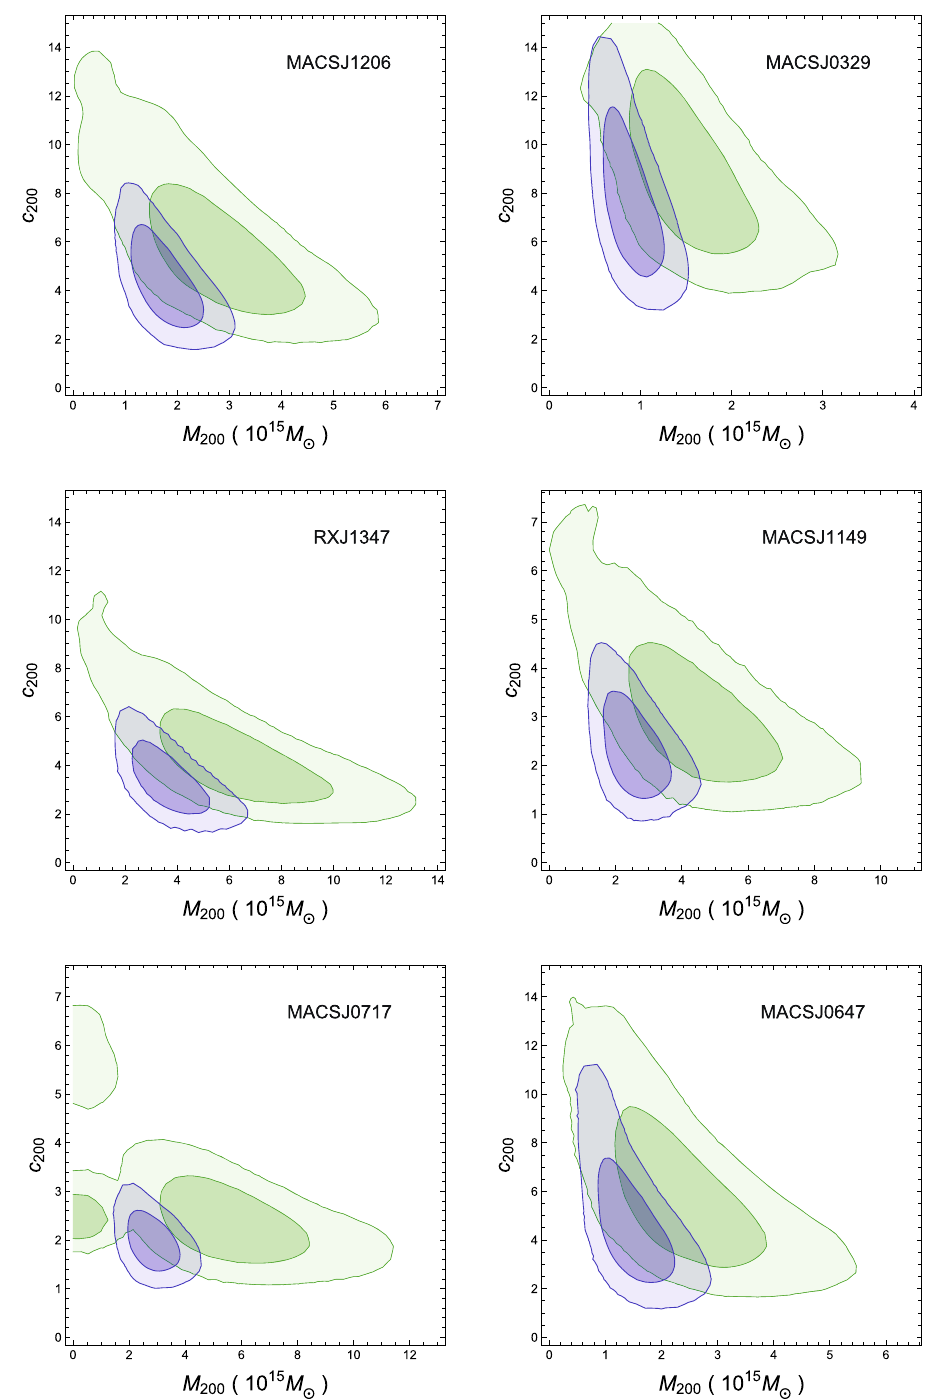
Fig. 5 Contour plot: blue—GR;